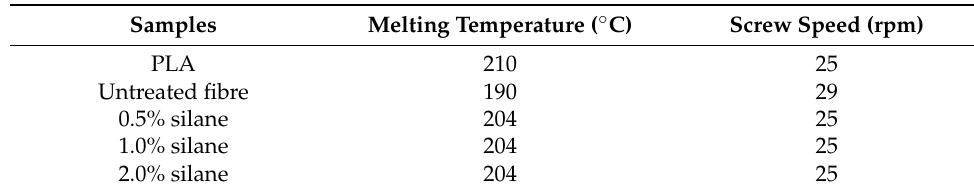
Table 4. Parameter of extrusion.